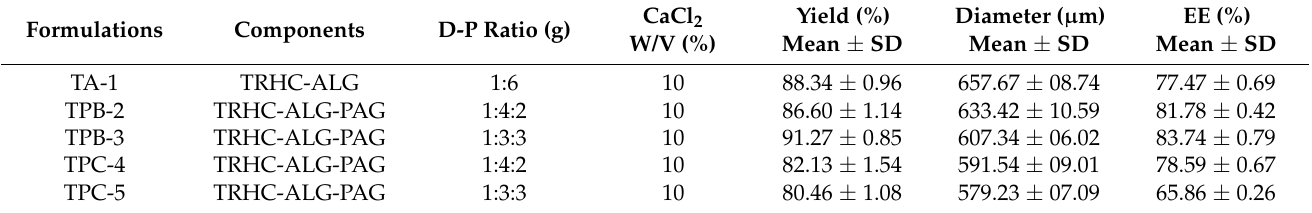
Table 4. Composition, % yield, particle diameter, and encapsulation efficiency of TRHC-PAG-alginate